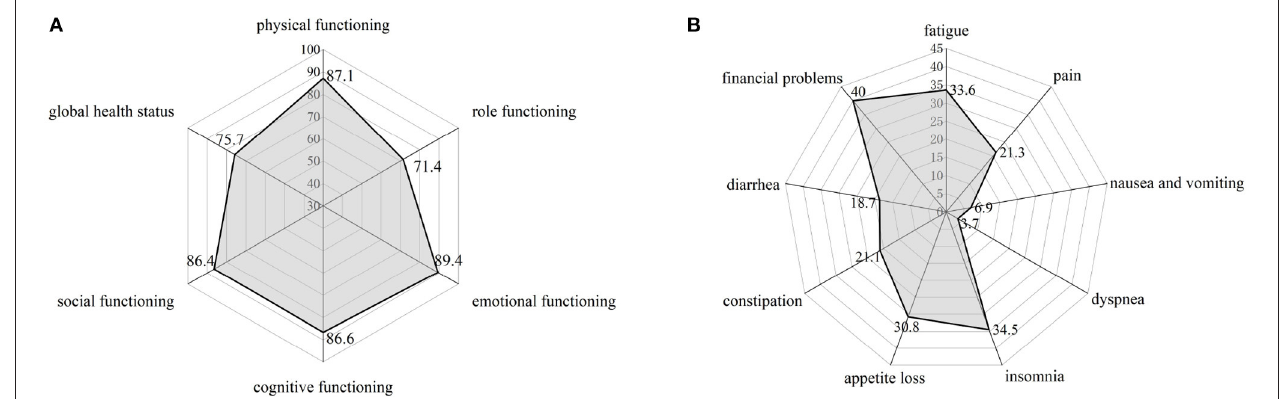
FIGURE 11 | HRQoL score according to overall global health status (A) , sub-domains of functioning (A) and symptoms (B) .